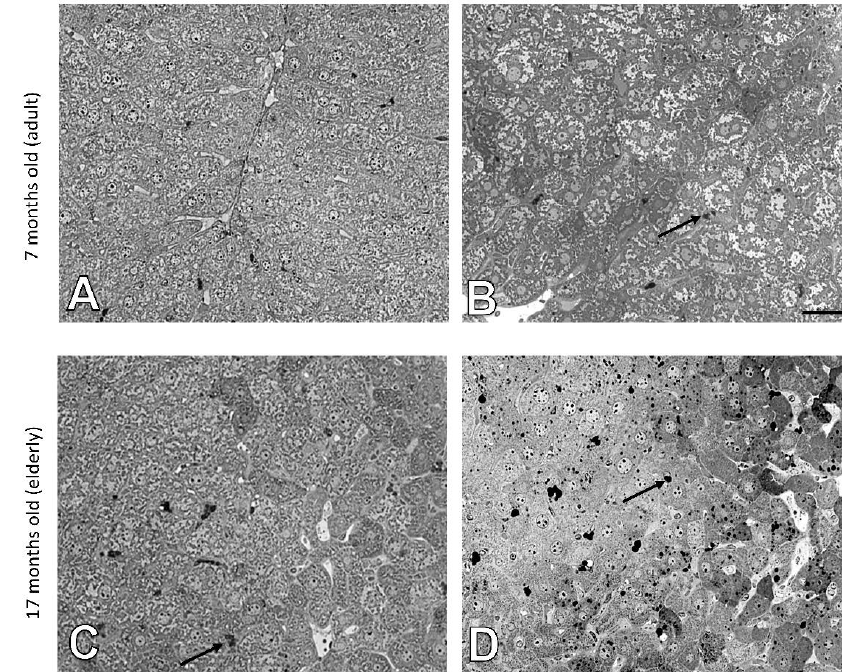
Figure 1. Age-related effects in the mouse liver. Semi-thin sections of mouse liver of 7-month-old ( A ) and 17-month-old C57Bl/6J mice ( C ); 7-month-old ( B ), and 17-month-old ApoE − / − mice ( D ). Arrows indicate lipid droplets. Scale bar = 20 μm.